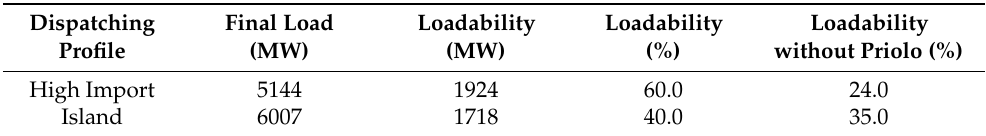
Table 22. Loadability margins for the selected DPs for 2050 with a full RES reactive contribution at Priolo as a synchronous compensator.